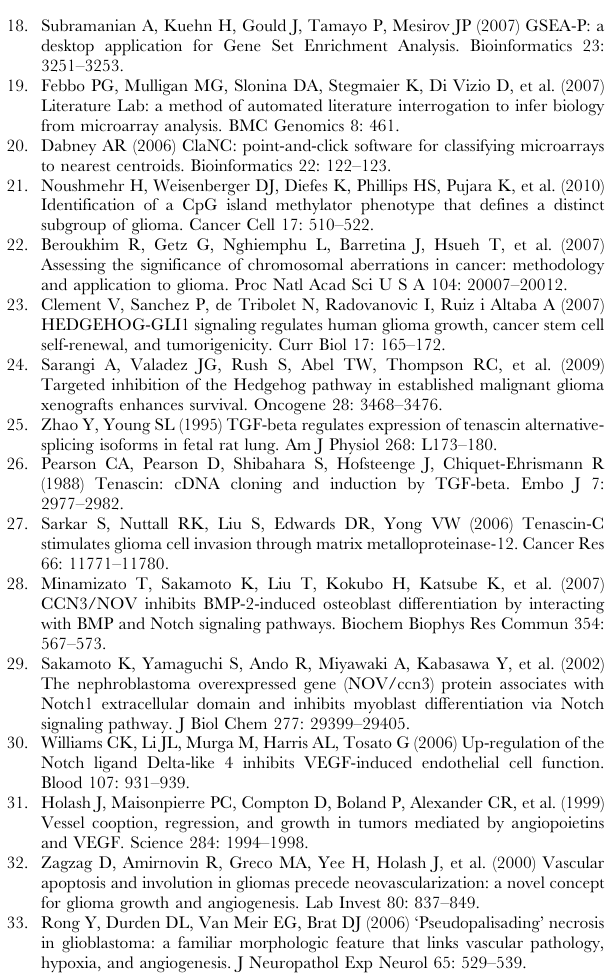
Table S10 Gene Ontology analysis of the 129 genes differen- tially expressed between proneural oligodendrogliomas and the all other oligodendrogliomas.